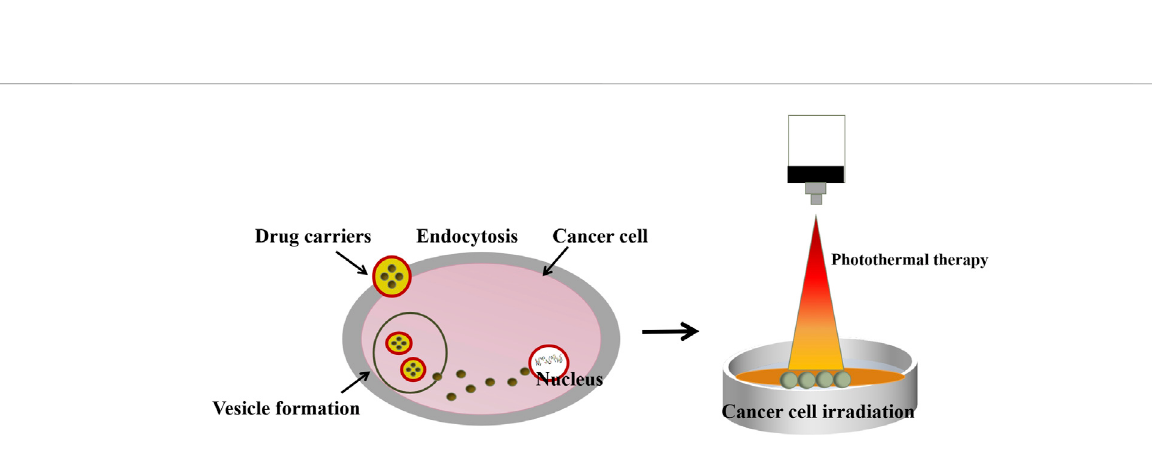
FIGURE 7 Schematic diagram of endocytosis mechanism and photothermal therapy (Kim et al., 2019).